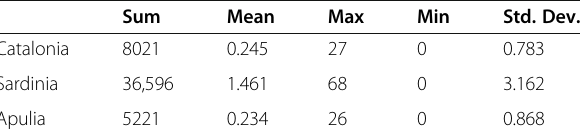
The Negative Binomial Hurdle model is recommended Table 2 Statistics of FIPs distribution in the three study regions Catalonia, Sardinia, and Apulia for the 2000 – 2012 time period when the observed outcome has an average lower than its variance (Spano et al. 2019), Sum Mean Max Min Std. Dev. Catalonia 0.783 Sardinia 36,596 3.162 0.868 where Γ is the gamma function, and Θ and λ represent function parameters (Li et al. 2020). The hurdle() func- tion from the R “ pscl ” package (Jackman 2017) was used for the analysis. The same explanatory variables were used for the hurdle and count parts, and a separate model was created for each of the three regions. For each part (hurdle and count), the predictions were extracted and used to calculate fire ignition maps.